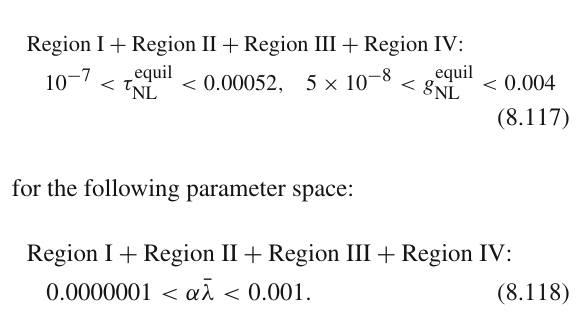
Region I + Region II + Region III + Region IV